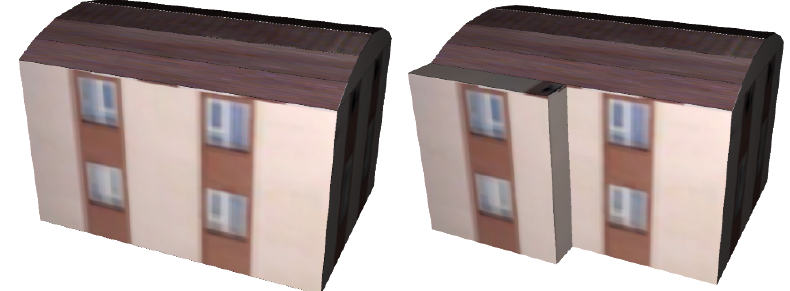
Figure 19. Face split operation.